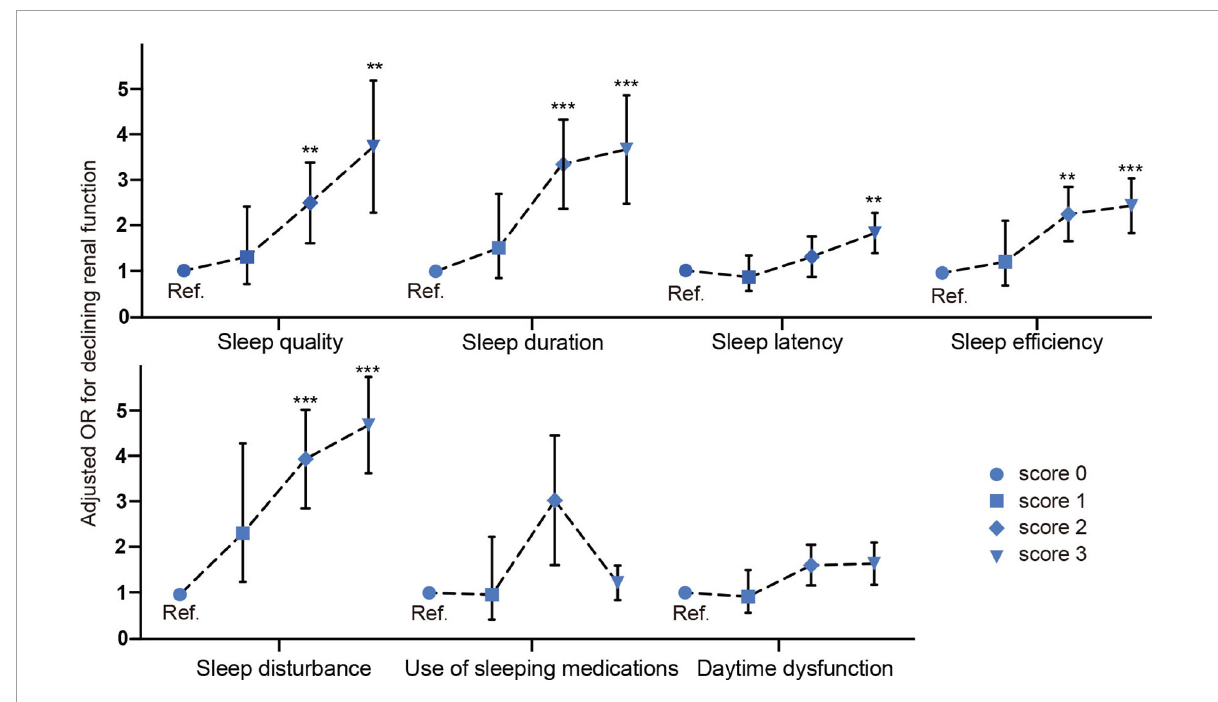
FIGURE3 Odds ratio of each sleep parameter of PSQI for declining renal function. ** p < 0.05, *** p < 0.001.